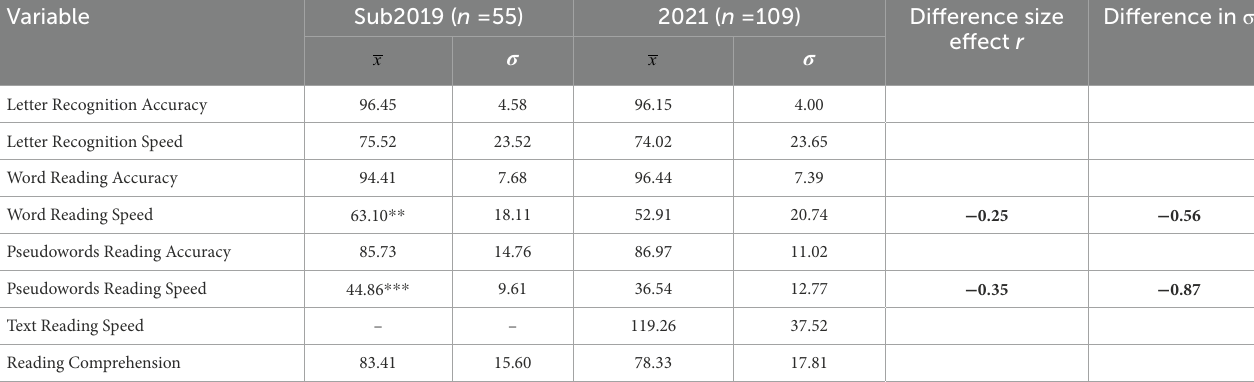
TABLE 4 Results in reading performance variables in sixth grade, pre- and